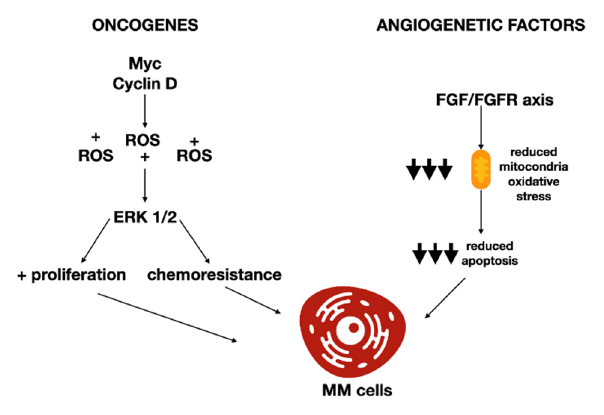
Figure 1. Oncogenes and angiogenetic factors’ oxidative stress interplay in